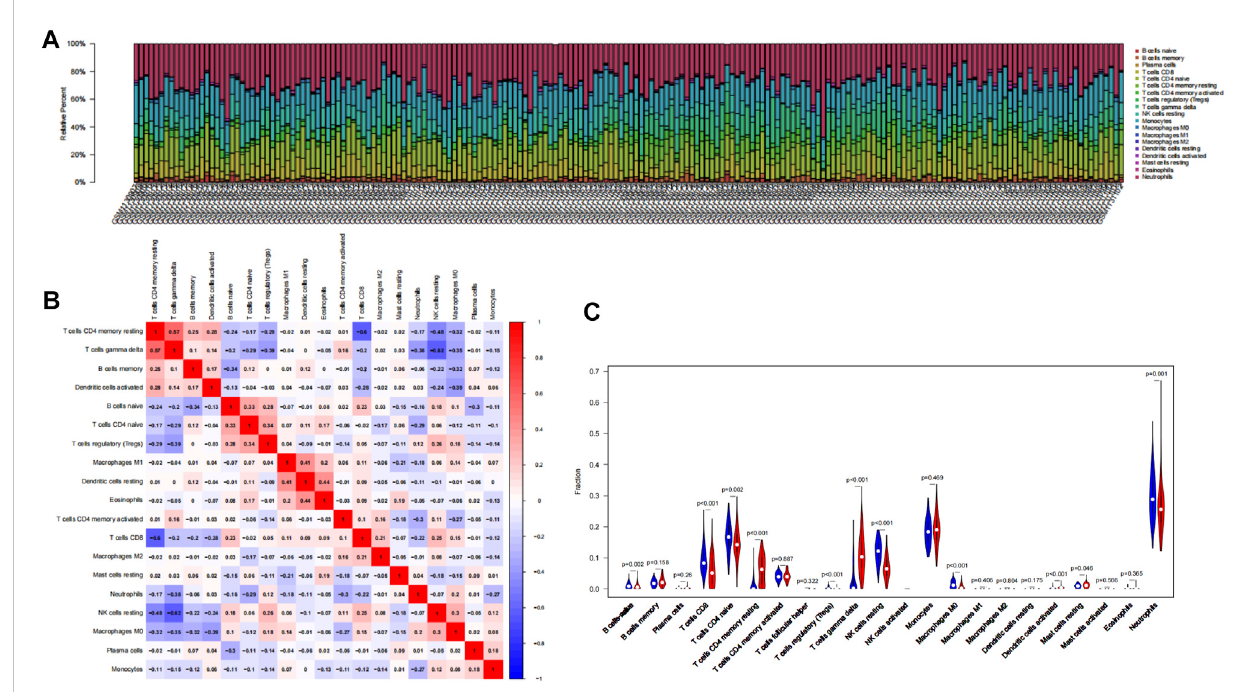
FIGURE 7 ResultsofCIBERSORTanalysisofGSE46480. (A) Landscapeofimmunecellin fi ltration. (B) Correlationmatrixofin fi ltrationdegreeofimmunecellsin samples at high altitude. Red indicates trends consistent with the positive correlation, and blue indicates trends consistent with the negative correlation between two immune cells. The bigger the statistics of the number data, the more positive or negative correlation. (C) Violin diagram of immune cell proportions in two groups. The blue fusiform fractions on the left represent the basecamp group, and the red fusiform fractions on the right represent the high-altitude group.